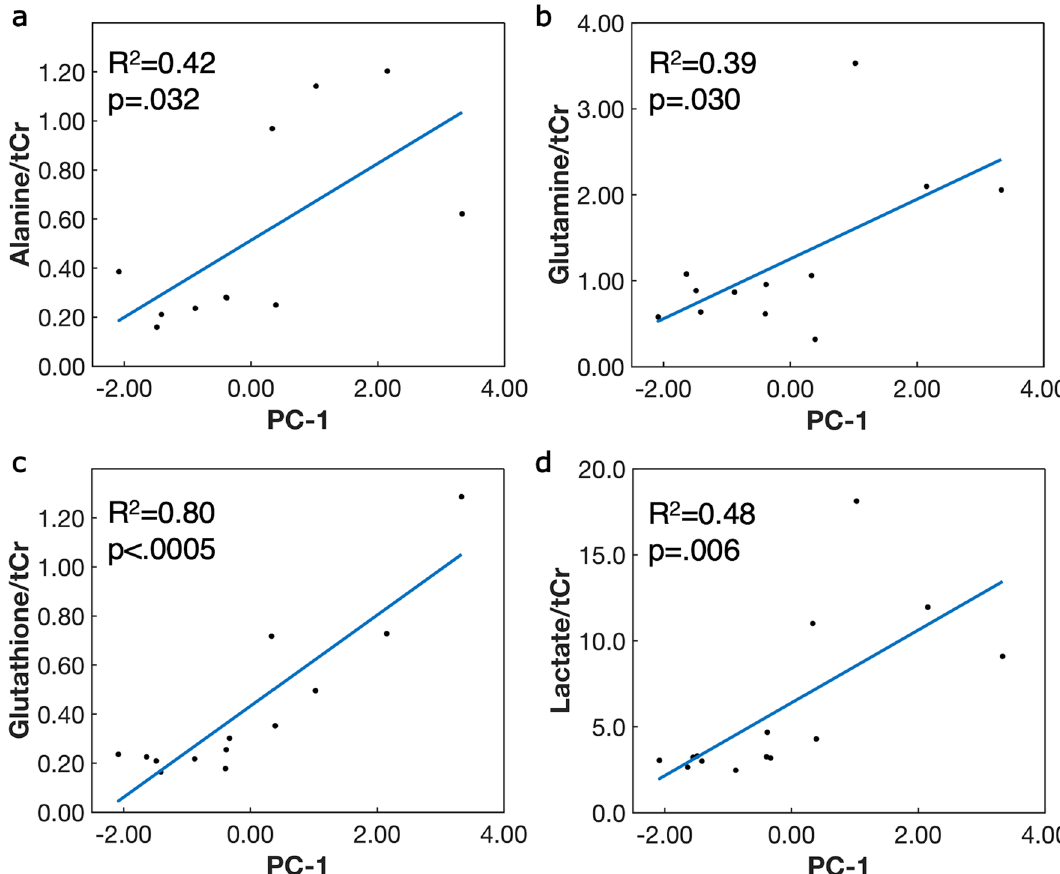
Figure 4. Significant associations between tumor metabolite concentrations and inflammatory marker principal component-1 (PC-1). PC-1 contains contributions primarily from interleukin (IL)-1α, IL-1β, and IL-8. Solid black circles represent raw data and blue line is the linear least-squares regression. Significant positive associations were observed between ( a ) alanine, ( b ) glutamine, ( c ) glutathione, and ( d ) lactate with inflammatory marker PC-1. Metabolites were normalized to creatine + phosphocreatine (tCr). Significance was determined by p ≤